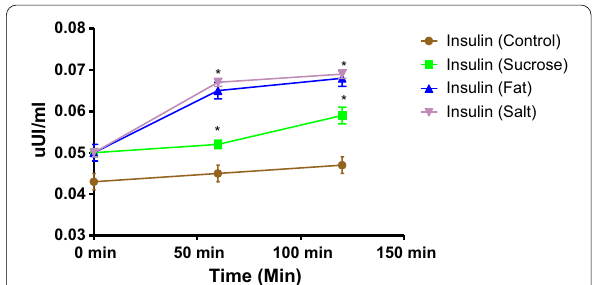
Fig. 2 The effect of high fat, high sucrose and high salt diet on the blood insulin level of experimental rats. Data are expressed as mean SEM ( n 10). * p < 0.05; ** p < 0.01; *** p < 0.001 are considered ± = significant when compared with